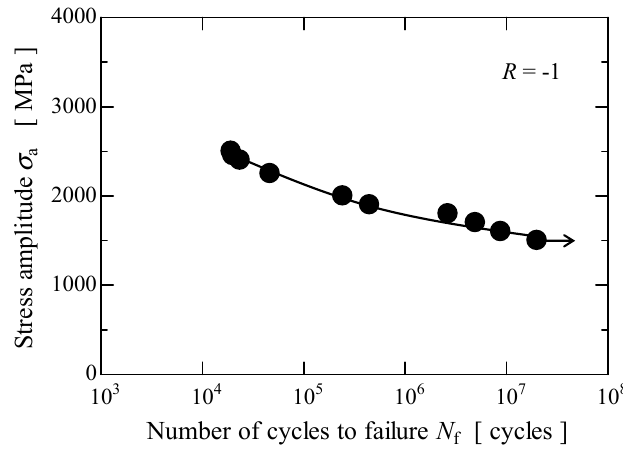
Figure 6. S - N curve for the fine-grained WC-Co cemented carbide.